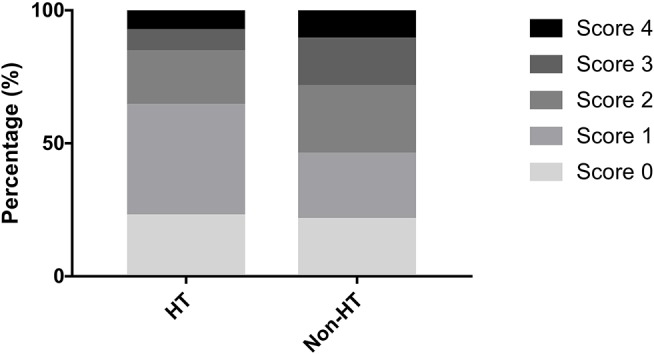
Percentages of different cerebral SVD scores in patients with or without HT.